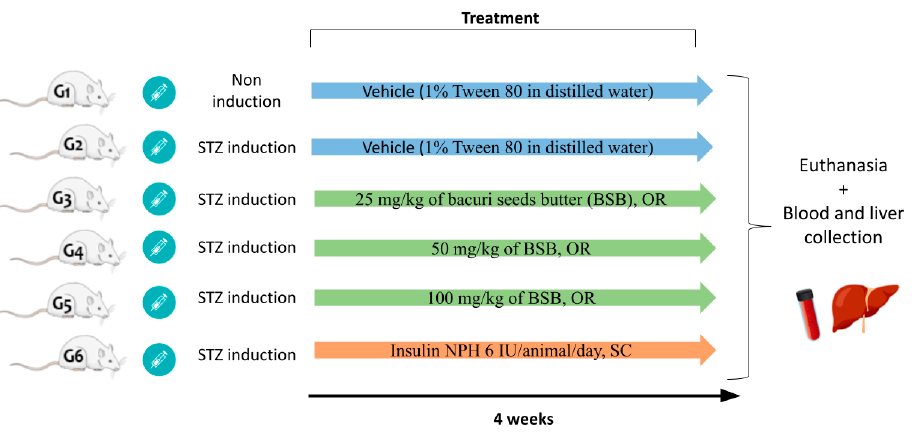
Figure 1. Graphical scheme of the experimental protocol of diabetes and BSB